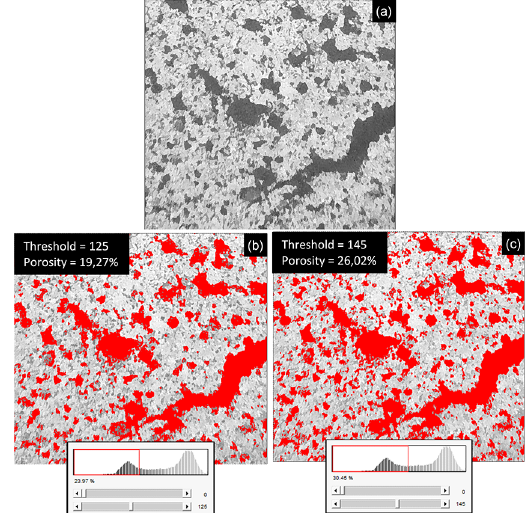
Figure 9. (a) Magnified region of the original image; (b) Segmentation: Threshold = 125, Porosity = 19,27%; (c) Segmentation: Threshold = 145, Porosity =